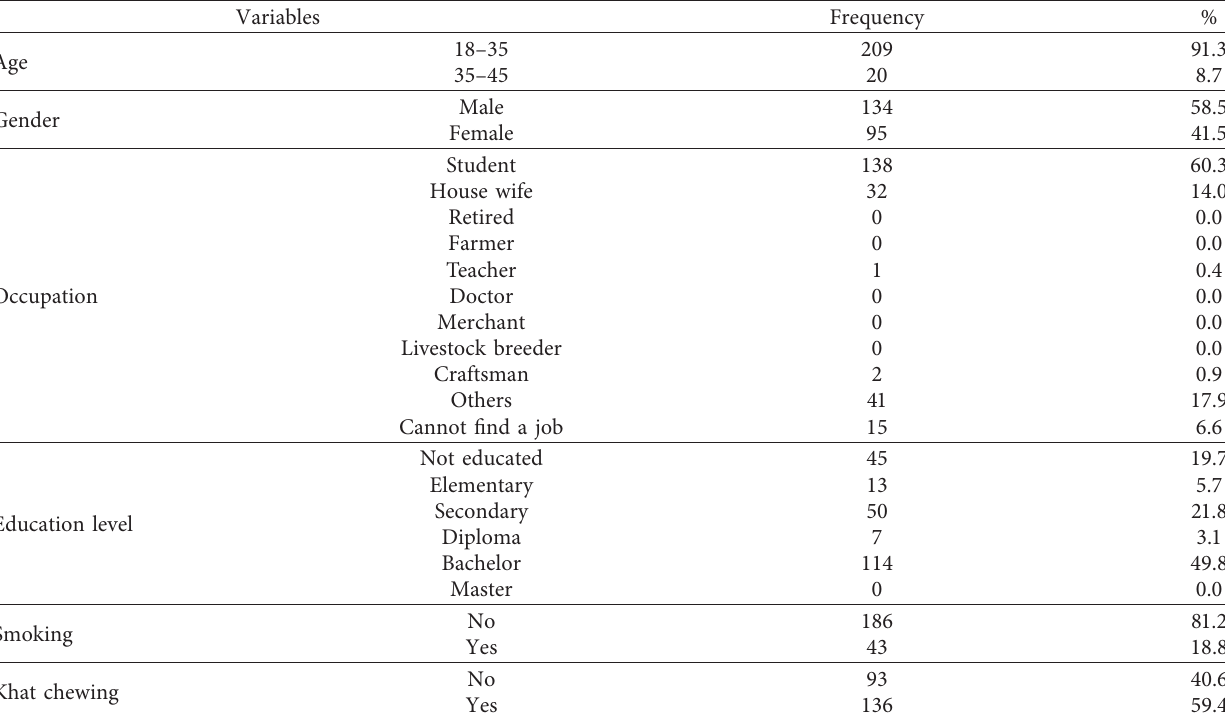
Table 1: Sociodemographic characteristics of the study